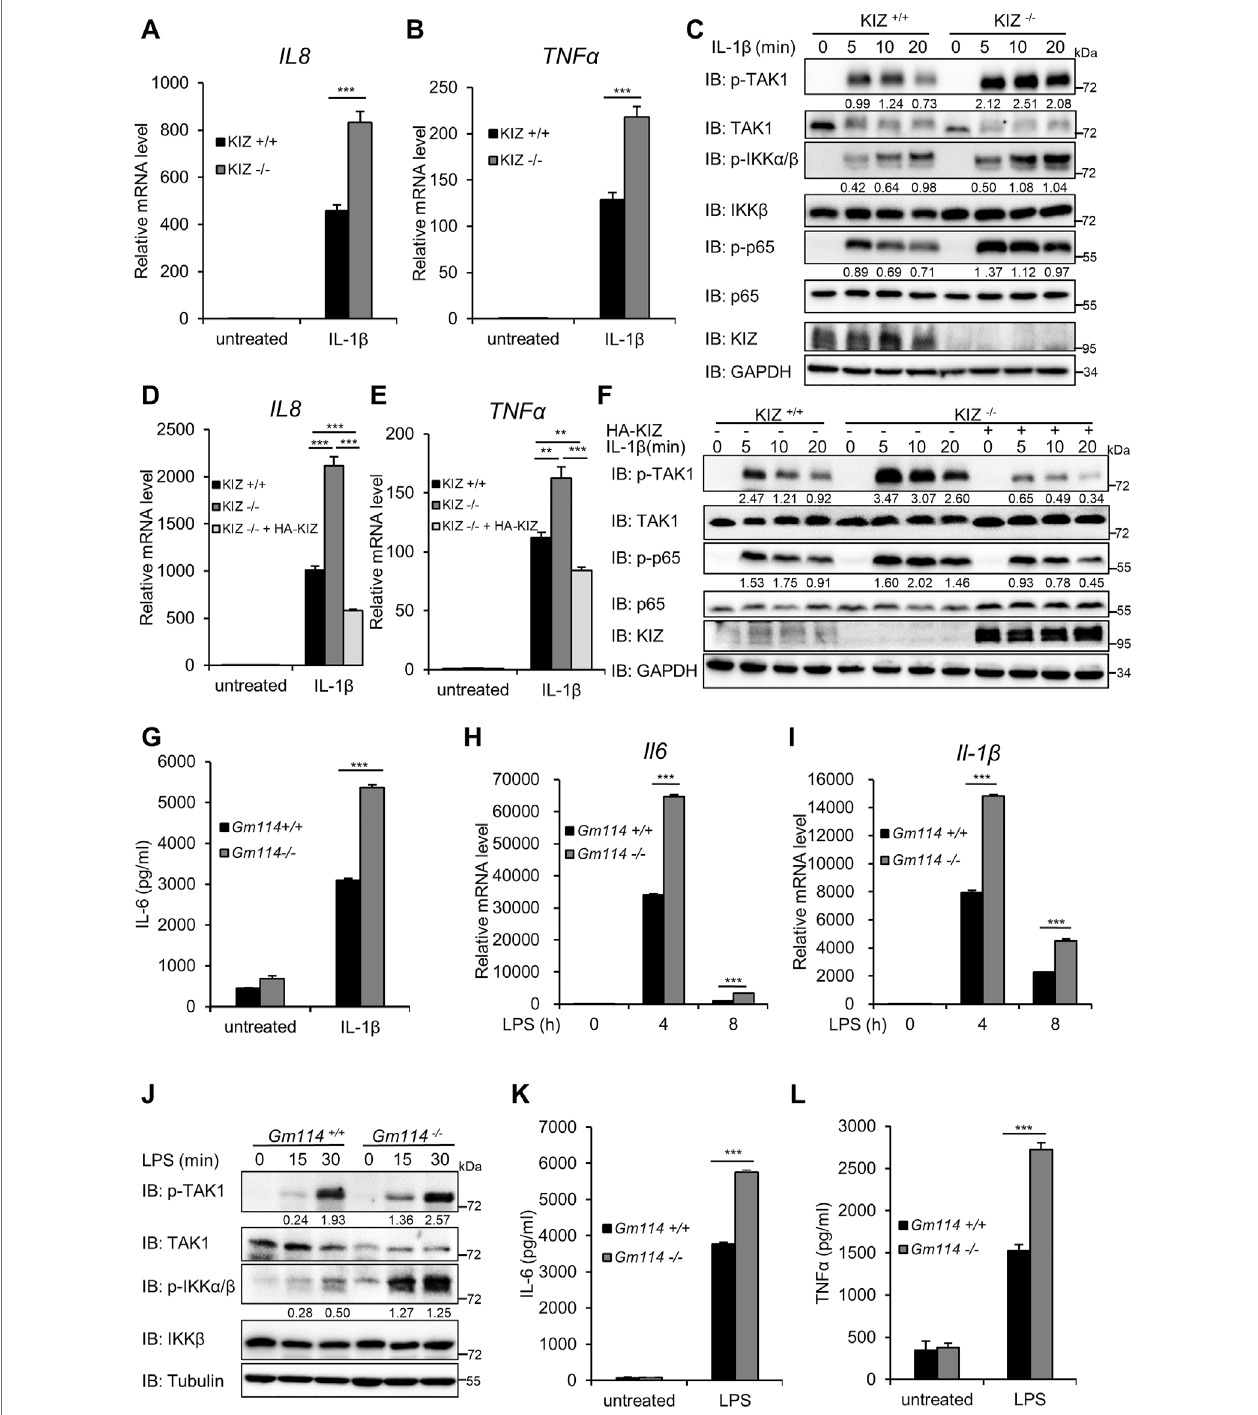
FIGURE3| KIZ/Gm114de fi ciencypromotesIL-1 β /LPS-inducedNF- κ Bactivation. (A – C) KIZ +/+ and KIZ − / − HEK293C6cellswereuntreatedortreatedwithIL-1 β (5 ng/ml)for 3 h,followedbyqPCRtomeasurethemRNAlevelsof IL8 (A) and TNF α (B) orstimulatedfortheindicatedtimesforimmunoblotting (C) . (D – F) WTandKIZknockoutHEK293C6cells were transfected with the KIZ expression plasmid or empty vector as indicated. After 24 h, the cells were untreated or treated with IL-1 β (5 ng/ml) for 3 h, followed by qPCR to measurethemRNAlevelsof IL8 (D) and TNF α (E) ortreatedfortheindicatedtimes,followedbyimmunoblotting (F) . (G) Gm114 +/+ and Gm114 − / − MEFsweretreatedwithIL-1 β (2 ng/ml) for 24 h and then analyzed by ELISA to measure IL-6 in the culture supernatant. (H – J) BMDMs were isolated from 8-week-old Gm114 +/+ and Gm114 − / − mice, and untreatedortreatedwithLPS(100 ng/ml)fortheindicatedtimesandthenanalyzedbyqPCRtomeasurethemRNAlevelsof Il6 (H) and Il-1 β (I) orsubjectedtoimmunoblotting (J) . (K,L) Gm114 +/+ and Gm114 − / − BMDMsweretreatedwithLPS(100 ng/ml)for24 handthenculturesupernatantswerecollectedtomeasureIL-6 (K) andTNF α (L) byELISAs.Data shown in (A,B,D,E,G – I,K,L) are from one representative experiment of three independent experiments (mean ± SD, n = 3). ** p < 0.01; *** p < 0.001; two-tailed Student ’ s t-test.